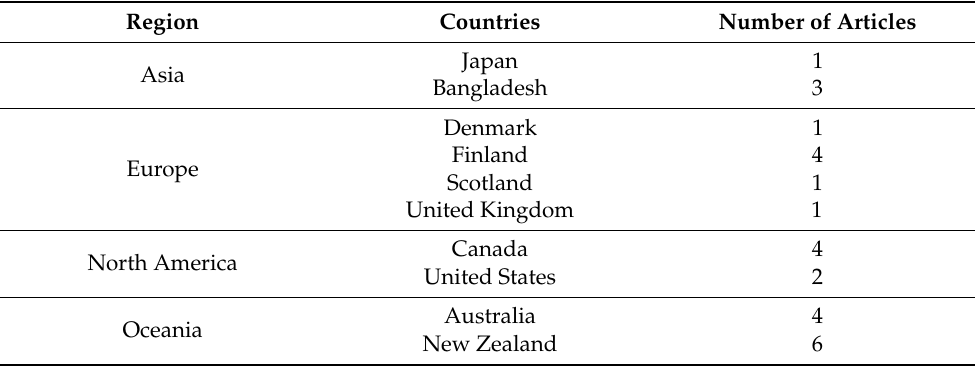
Table 1. Articles reviewed and included by region and